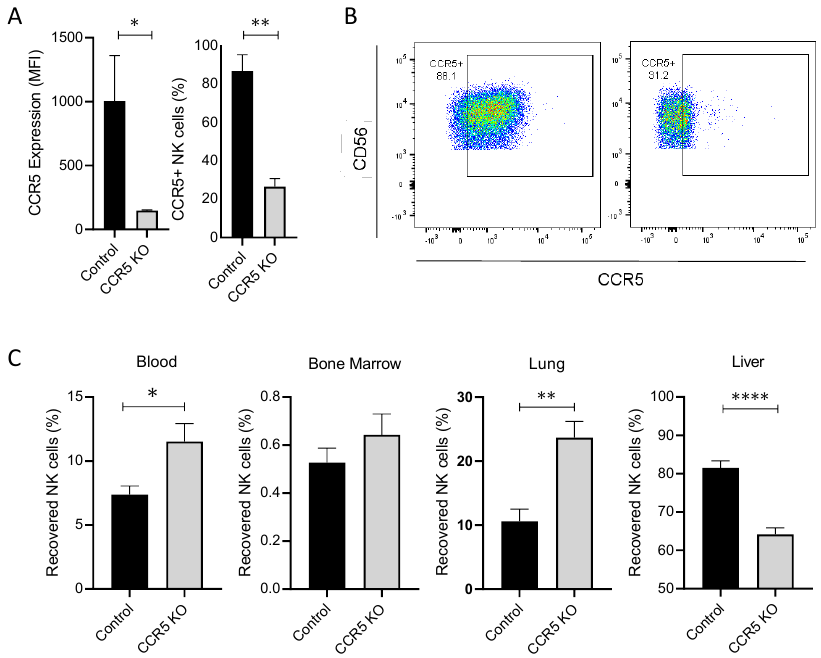
Figure 6. Reduction of CCR5 expression significantly reduces NK cell trafficking into the liver 24 h following NK cell infusion into mice. ( A ) Bar graphs that illustrate CCR5 positivity and surface expression on ex vivo expanded NK cells ( n = 4 donors). ( B ) Dot plots representing CCR5 surface expression on NK cells (one representative donor). ( C ) Plots displaying the fraction of NK cells that were recovered in tissues, 24 h following i.v. infusion into mice ( n = 8–9 mice per group, 2 independent experiments). Statistics determined with the Students t -test, two tailed, * p < 0.05, ** p < 0.01, **** p <